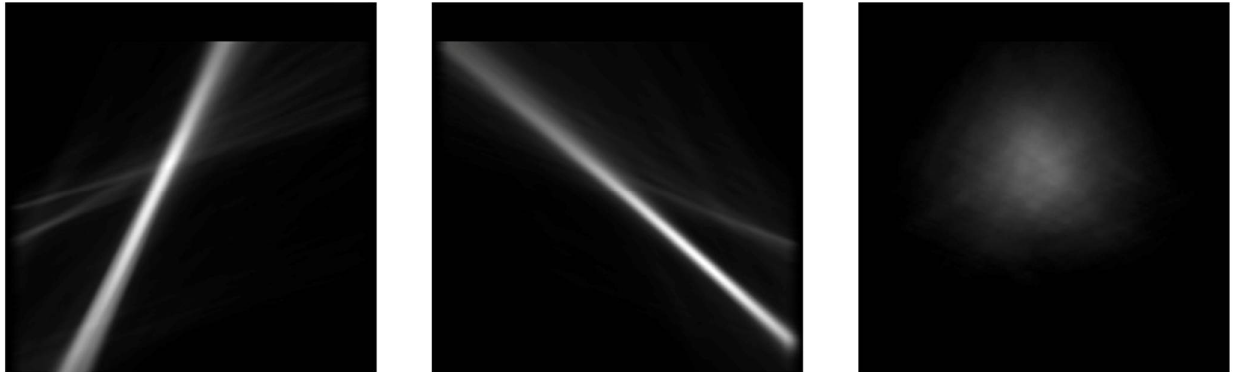
Figure 14. The vote-map features of the vanishing point: the left side features ( first image ), the right side features (center), and the multiplication result of the first two images (right).